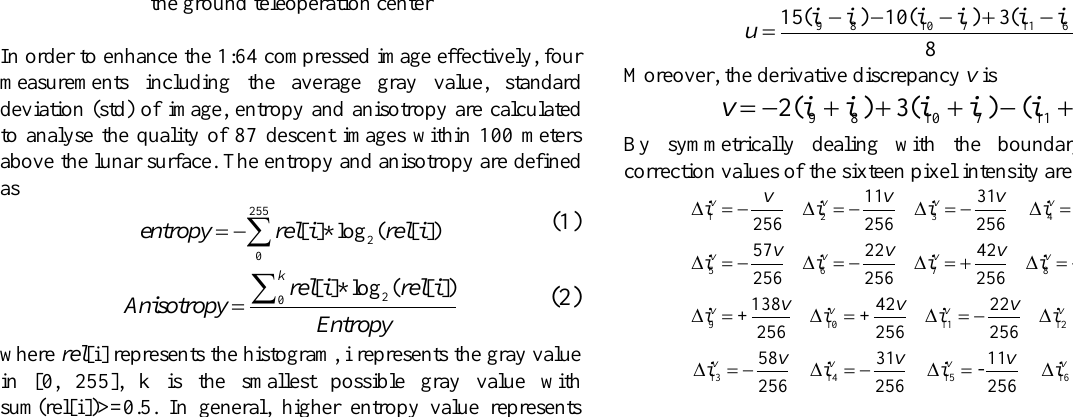
Figure 1. The first descent image and landing image received by the ground teleoperation center